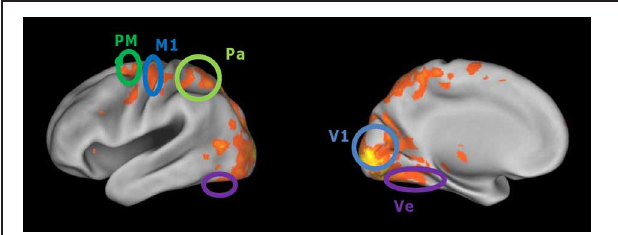
FIGURE 2 | Cortical regions activated more during virtual maze navigation than during resting blocks. Activity was thresholded at p < 0 . 0001 (corrected for multiple comparisons). The cortical regions of interest defined in our analyses are circled: primary visual cortex (V1), ventral visual cortex (Ve), superior parietal cortex (Pa), primary motor cortex (M1), and dorsal premotor cortex